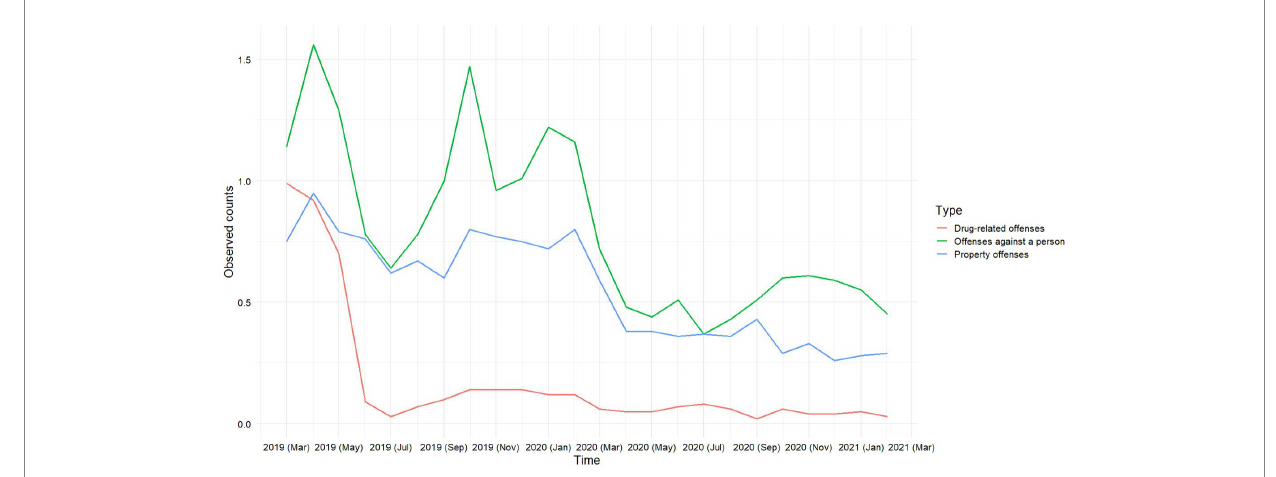
FIGURE 1 Longitudinal change of average observed counts of delinquency ( N = 138).